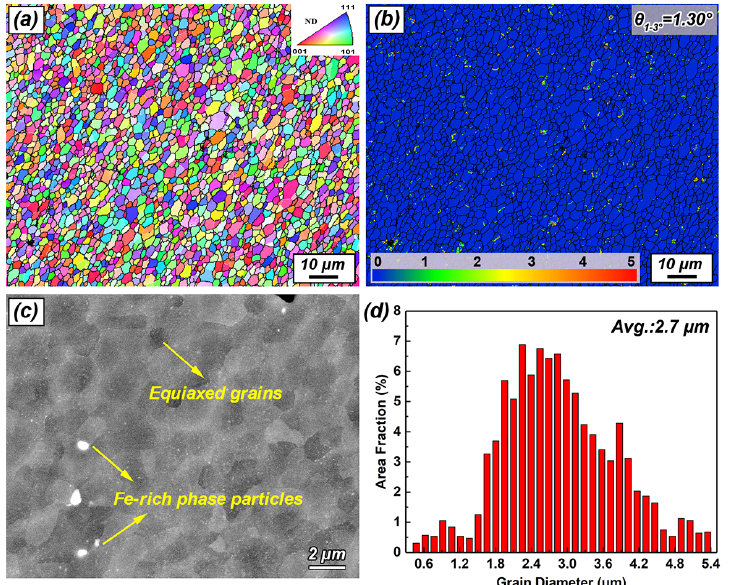
Figure 17. ( a ) IPF coloring map, ( b ) KAM map, ( c ) backscattered SEM image and ( d ) grain size distribution histogram of the annealed RBE (25 N) sample.